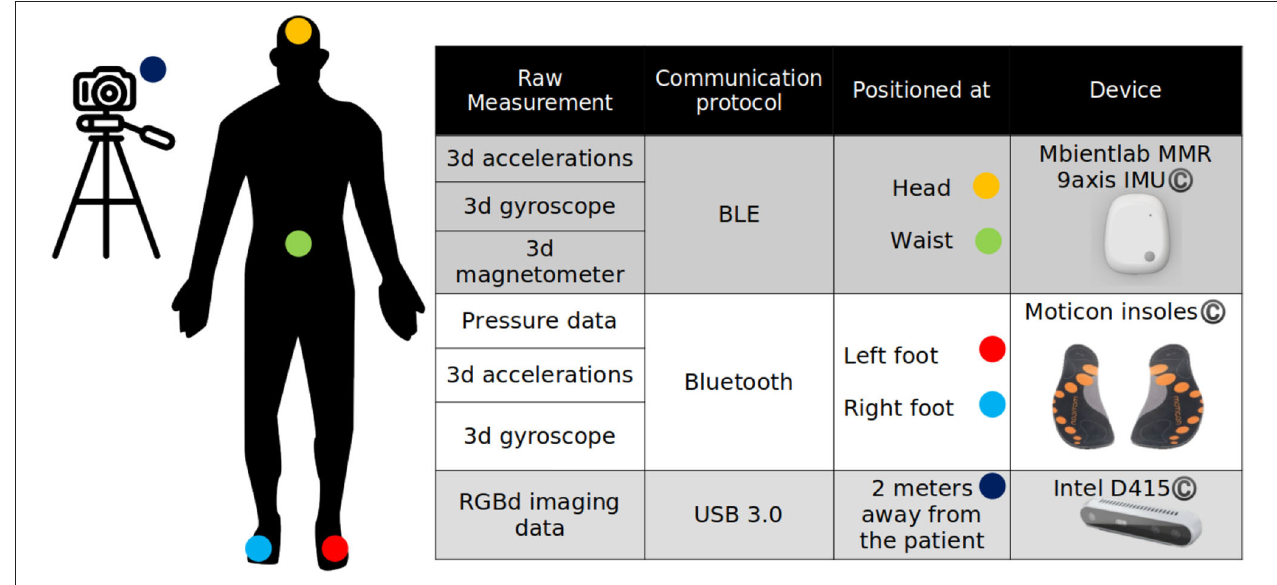
FIGURE 7 | Motion capture and exercise assessment module setup.